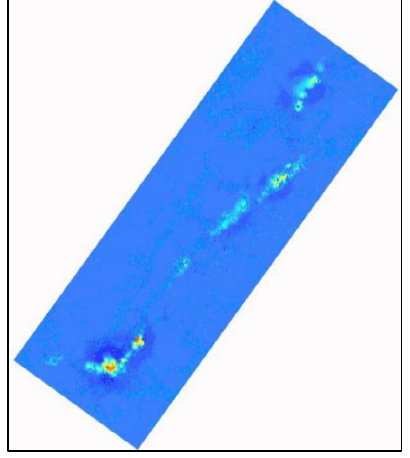
Figure 3. Deformation rate from 2007 to 2011